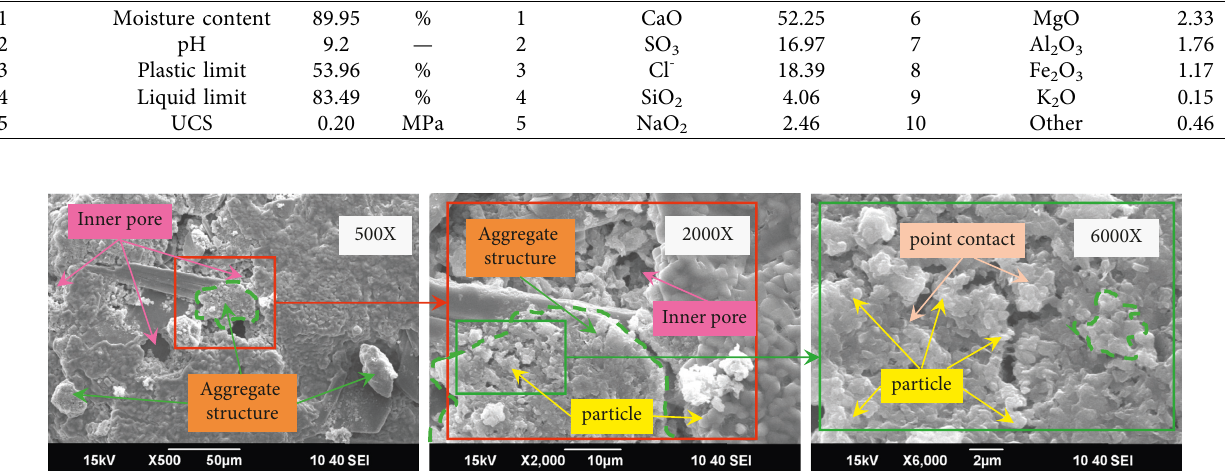
Figure 1: SEM micrographs of microstructure inside soda residue at different